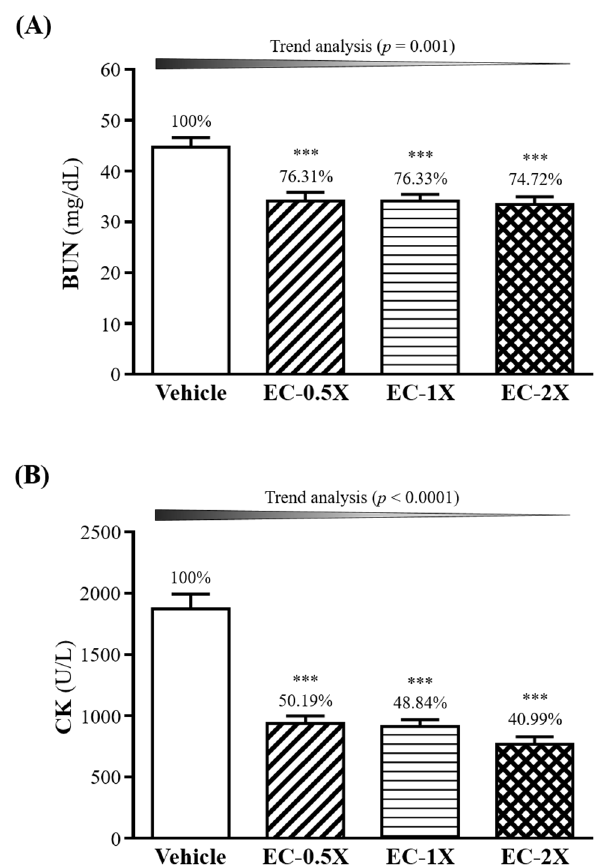
Figure 5. Effect of EC supplementation on ( A ) blood urea nitrogen (BUN) and ( B ) creatine kinase (CK) after 90 min swim test and 60 min rest. Mice were supplemented with the vehicle, EC-0.5X, EC-1X, and EC-2X for 28 days. Data is expressed as mean ± SEM ( n = 10). Numbers above bars indicate percentage (%) change with vehicle control fixed at 100%. Significant difference from control group according to one-way ANOVA is indicated *** p < 0.001.